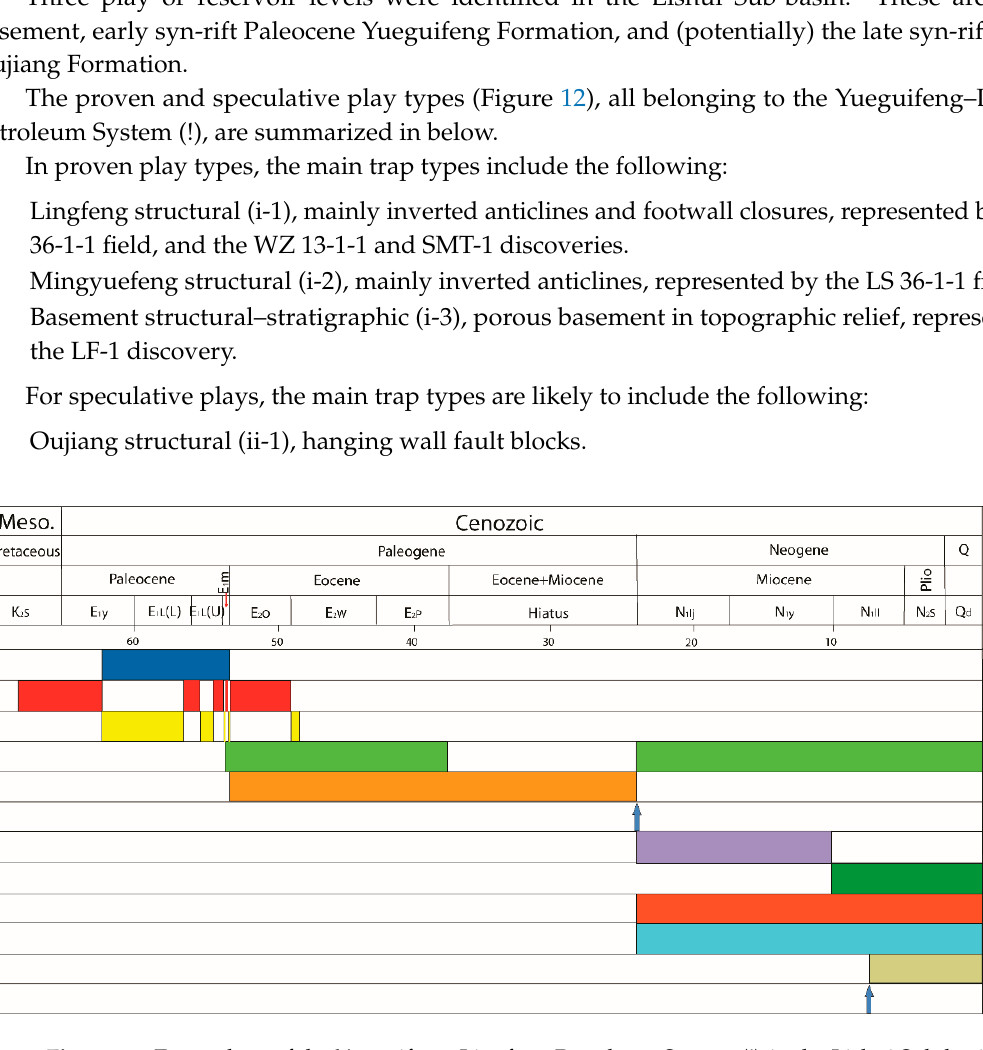
Figure 13. Event chart of the Yueguifeng–Lingfeng Petroleum System (!) in the Lishui Sub-basin.